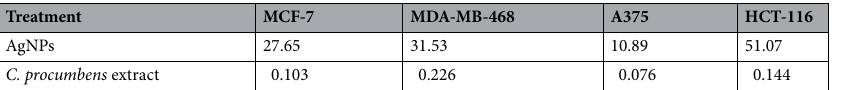
Table 3. Therapeutic indexes (µg/mL) for AgNPs and C. procumbens extract for different tumor cell lines compared to the macrophage cell line.